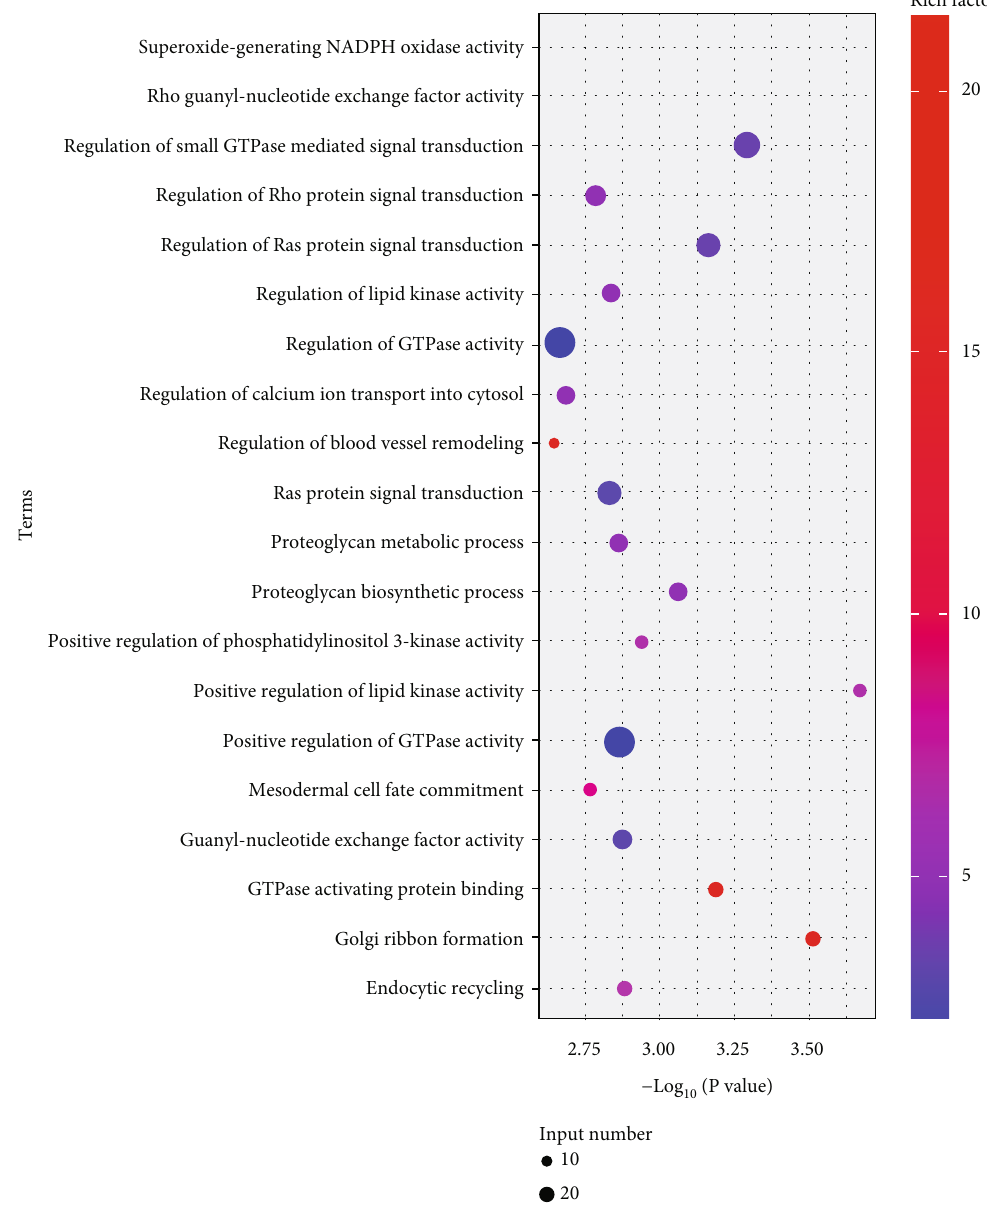
Figure 7: Potential proangiogenic ability of ADSC-EVs. Top 20 (according to P value) GO terms for miRNA target genes. The enrichment factor represents the ratio between the total number of genes in the input list and the number of annotated genes in the GO terms. The larger the enrichment factor, the higher the level of